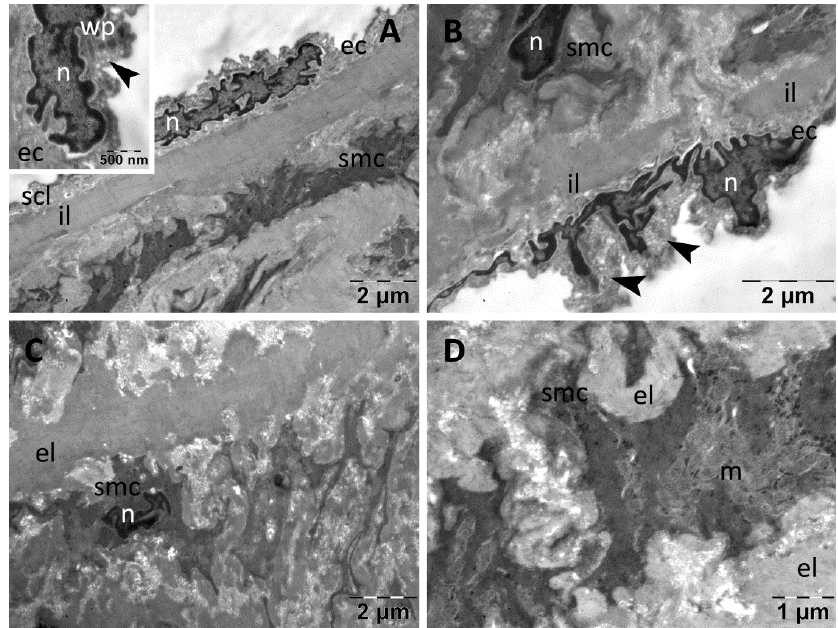
Figure 11. TEM investigation of the descending aorta in rats with HFD for 9 months; the last month with experimental-induced diabetes mellitus and with oral gavage AuNPsCM administration showed impacted ultrastructure: extremely thin intima with thin subendothelial connective layer and prominent endothelial cells containing vesicles of transcytosis and Weibel–Palade bodies ( A , B ); media showed normal ultrastructure ( C , D ) (arrowhead, vesicles of transcytosis; ec, endothelial cell; el, elastic lamina; il, inner elastic lamina; m, mitochondria; n, nucleus; scl, subendothelial connective layer; smc, smooth muscle cell; wp, Weibel–Palade bodies). In the aortas from the CM group, the intima was well represented: the endothelial cells had normal aspect and ultrastructure while the subendothelial connective layer was thick but heterogeneous, showing rarefied regions and regions consisting of compact packed, dense fibers (Figure 12A,B). The media contained smooth muscle cells with char- acteristic aspect, and the extracellular matrix was homogeneous (Figure 12C,D). All elastic laminae were homogeneous (Figure 12A–D).